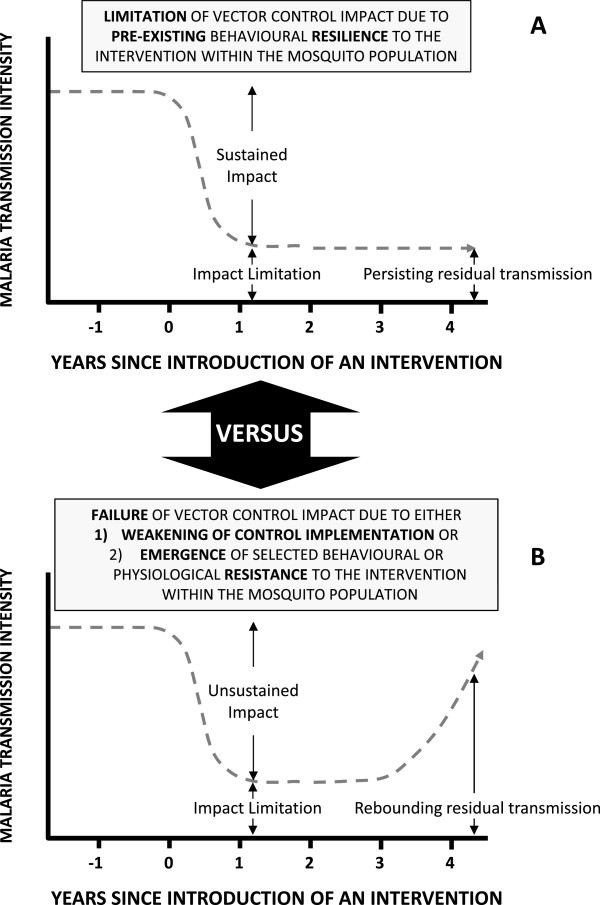
A schematic illustration of the differing trajectories of impact of an intervention upon malaria transmission by a vector population under the distinctive scenarios of either (A) stable limitation of sustained impact arising from expression of pre-existing behavioural traits within a resilient vector population, or (B) failure of impact and resurgence of malaria transmission when, either intervention programme implementation quality and coverage weakens, or selected behavioural or physiological traits emerge within an increasingly resistant, rebounding vector population[2,4,6,7][12].